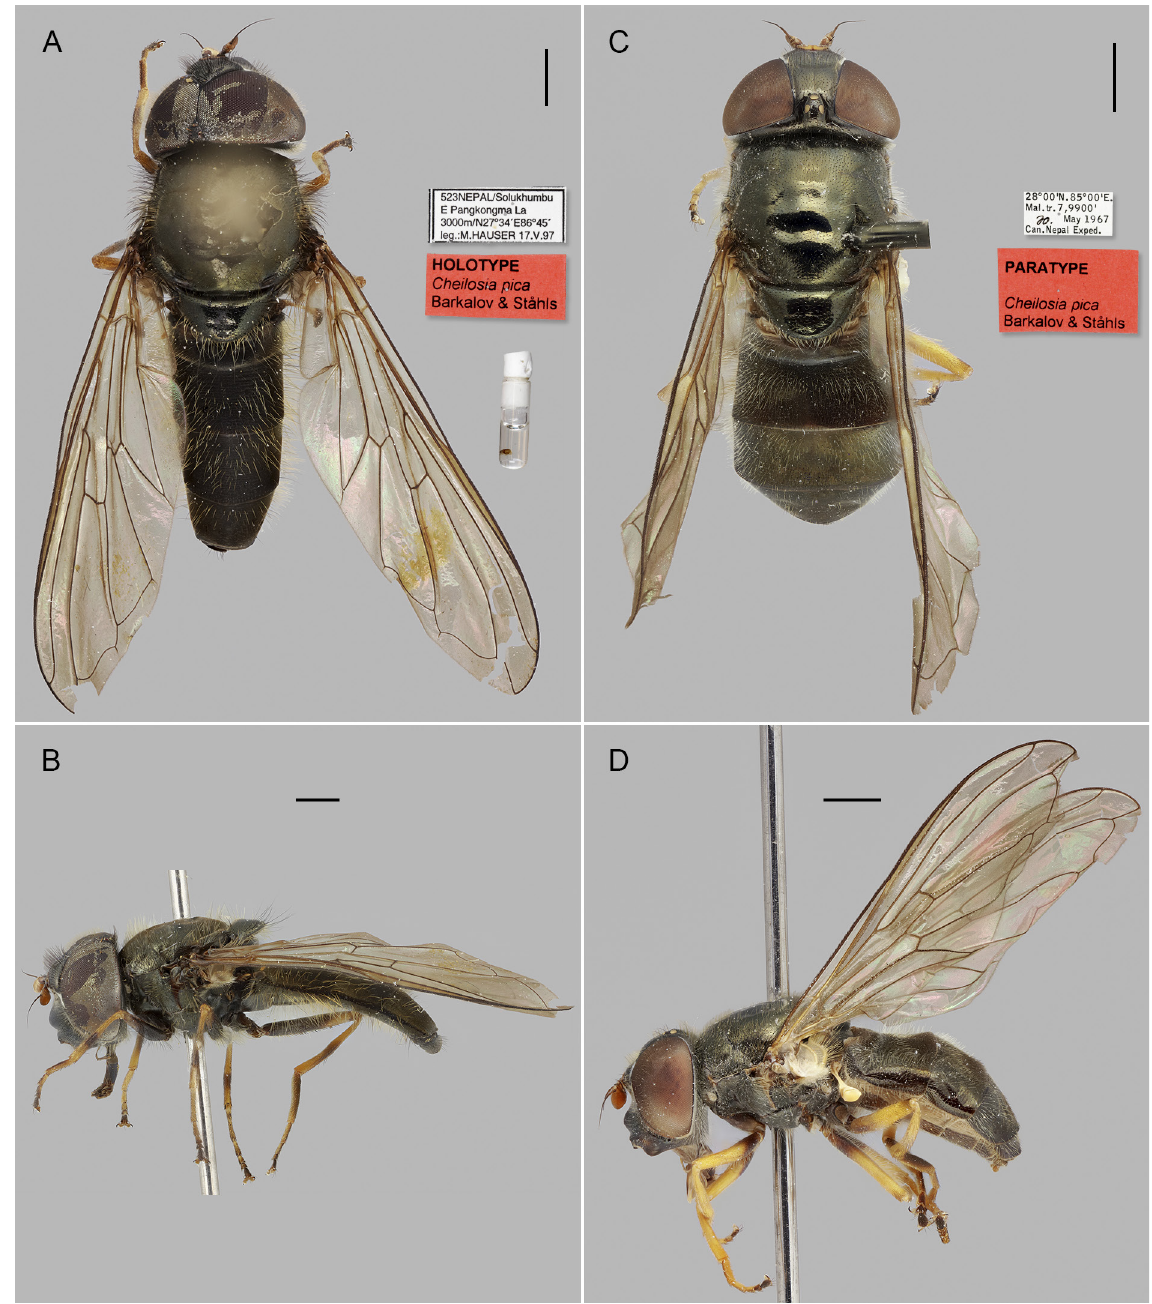
Fig. 49. Cheilosia ( Cheilosia ) pica sp. nov. A–B . Holotype, ♂ (CSCA); dorsal and lateral views. C–D . Paratype, ♀ (CNC); dorsal and lateral views. Photo: Pekka Malinen, FMNH Luomus. Scale bars = 1